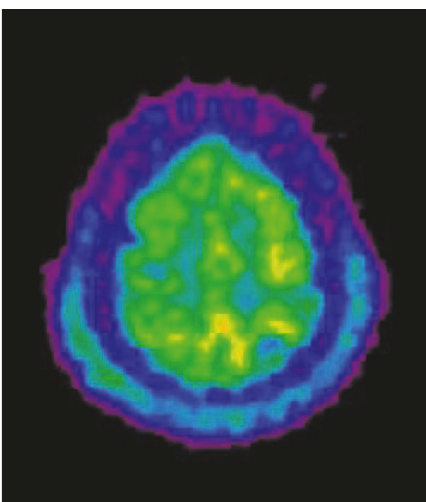
Figure 1: Brain 18 fluorodeoxyglucose (FDG) positron emission tomography (PET) showing diffuse cortical hypometabolism fea- tured by decreased uptake of the